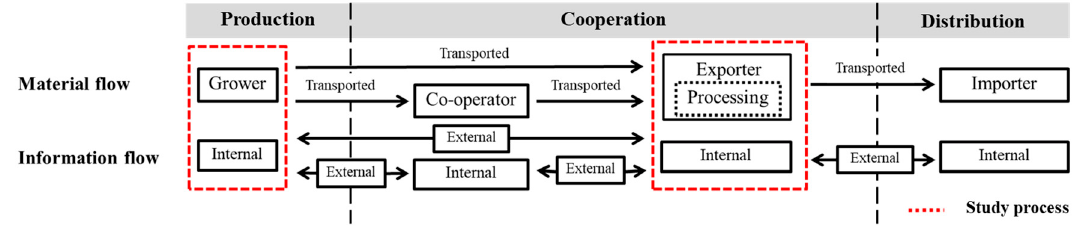
Figure 2 . Supply chain management of Thai mangoes for export . The boxes highlighted with the red Figure 2. Supply chain management of Thai mangoes for export. The boxes highlighted with the red dashed lines indicate the processes focused on in this study . dashed lines indicate the processes focused on in this study.